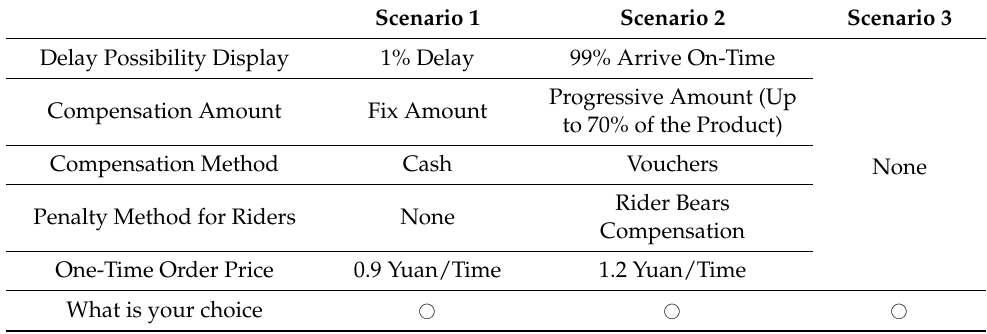
Table 2. A sample of choice